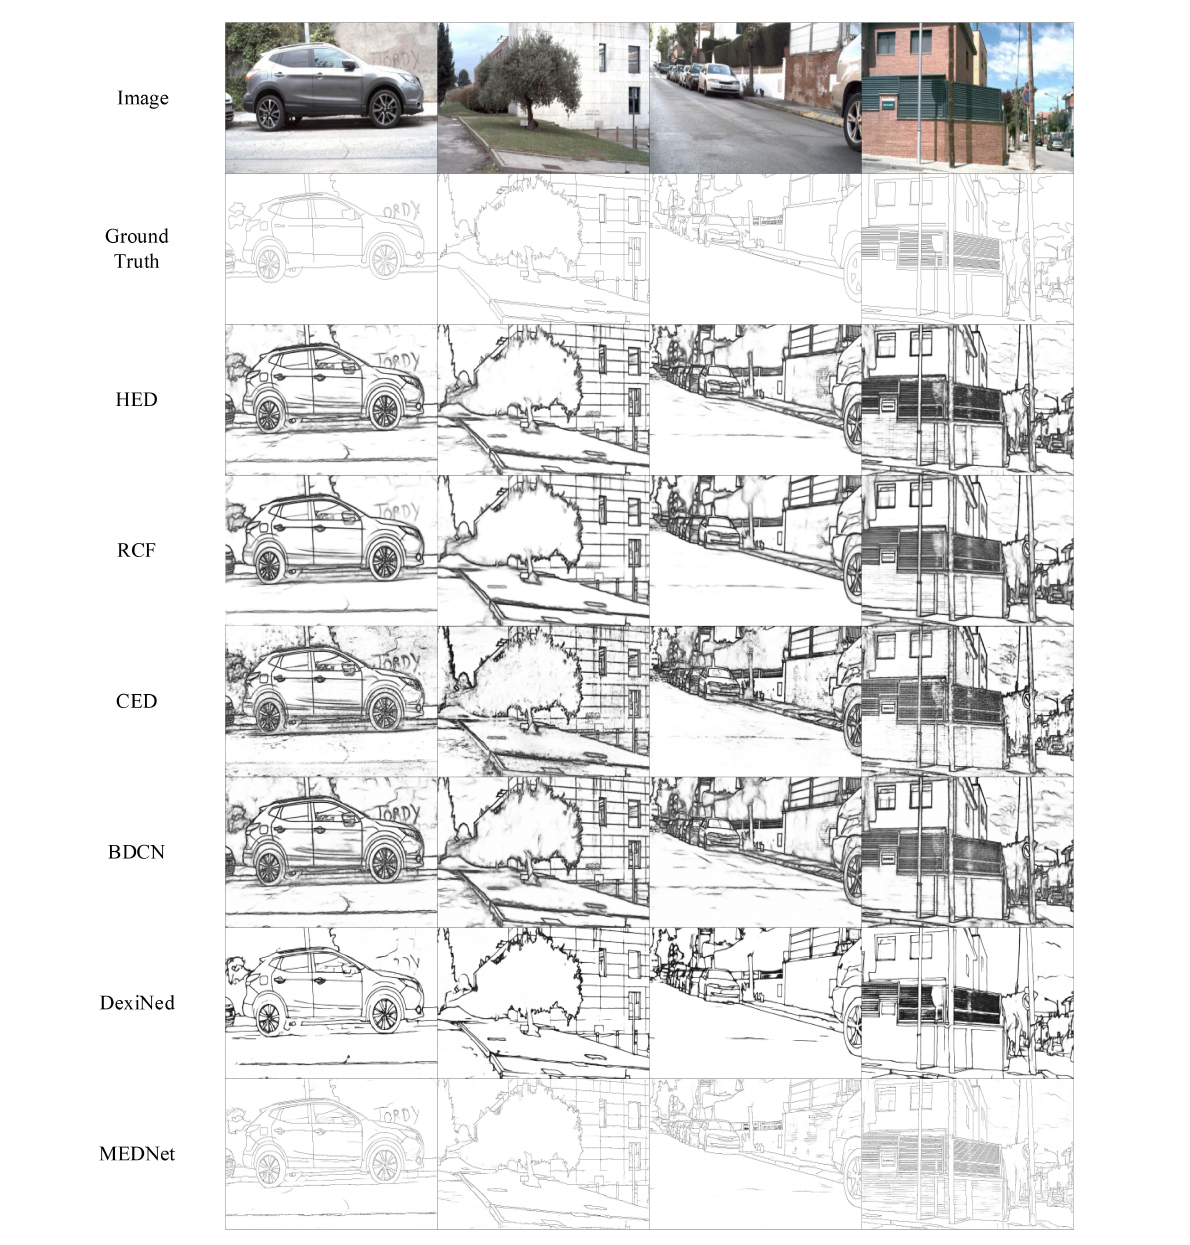
FIGURE10 Comparison of results of the proposed method with other methods on barcelona images for perceptual edge detection (BIPED) datasets. Among them, in order to make a fair comparison, the results of other methods are the same as those used in Poma et al. (2019). Source photos: BSDS500 dataset - publicly available